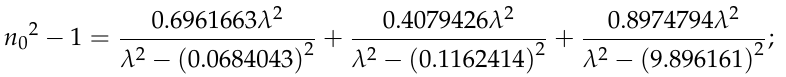
Figure 4. ( a ) Amplitude of the PEM retardation δ 0 and ( b ) PEM retardance.